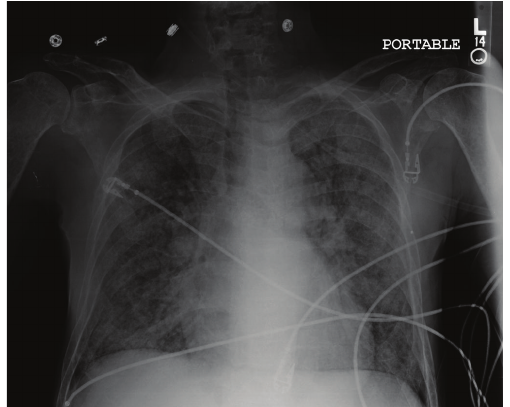
Figure 1: Chest X-ray AP view showing reticulonodular infiltrates and microcalcifications.